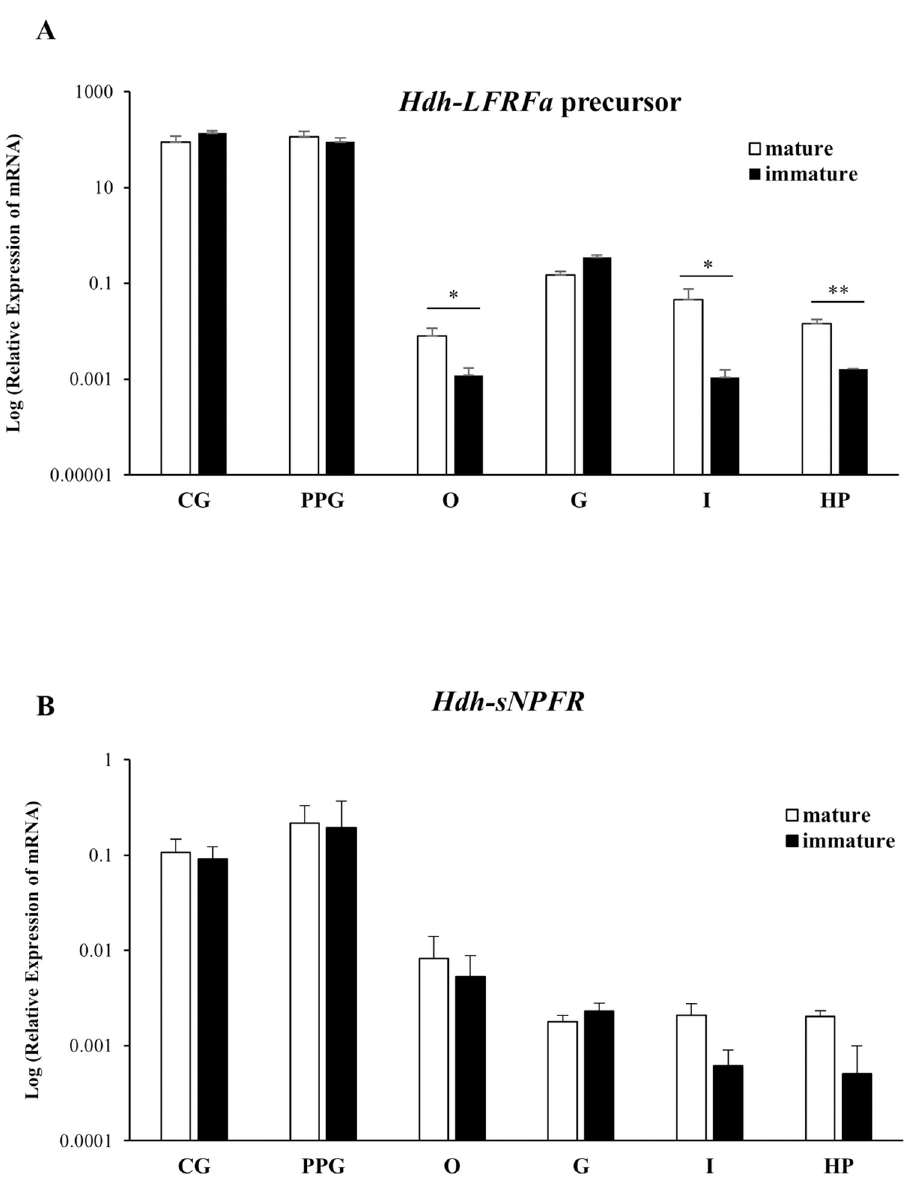
Fig 8. Relative expression levels of Hdh-LFRFa precursor and Hdh-sNPFR transcripts in various tissues of mature and immature female abalone. (A) Hdh-LFRFa precursor and (B) Hdh-sNPFR mRNAs were quantified by quantitative PCR and normalized in the log scale. All data represent mean ± SEM (n = 5); � p < 0.05, �� p < 0.01. CG: cerebral ganglion; PPG: pleuro-pedal ganglion; O: ovary; G: gills; I: intestine; HP: